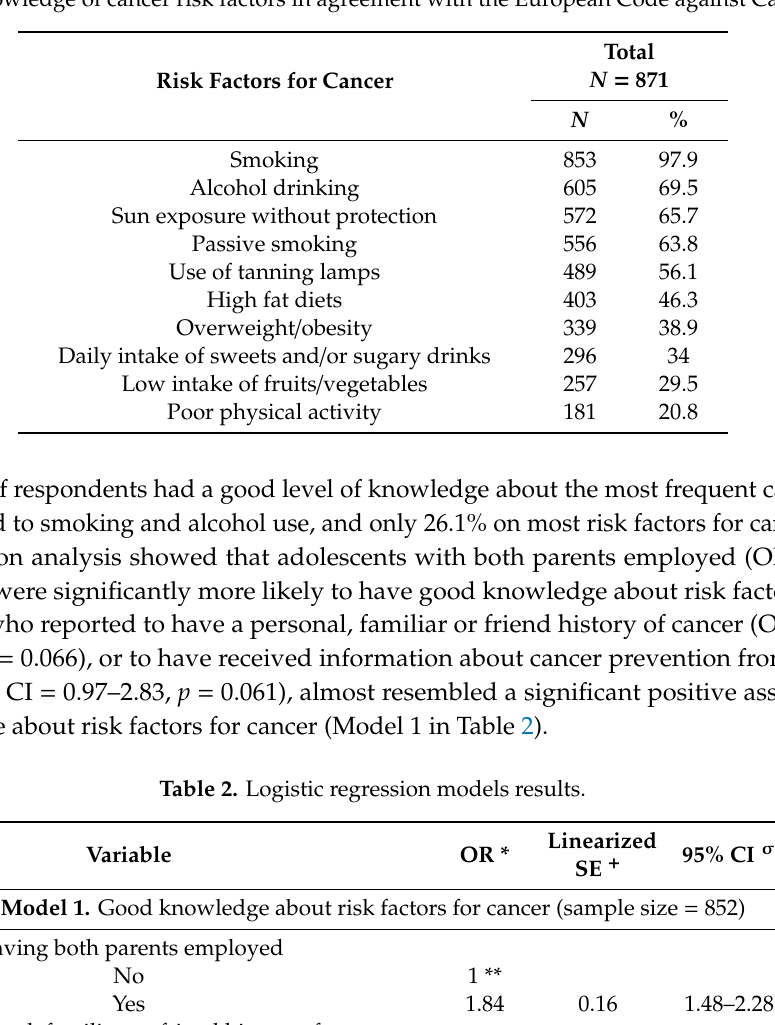
Table 1. Knowledge of cancer risk factors in agreement with the European Code against Cancer [17].